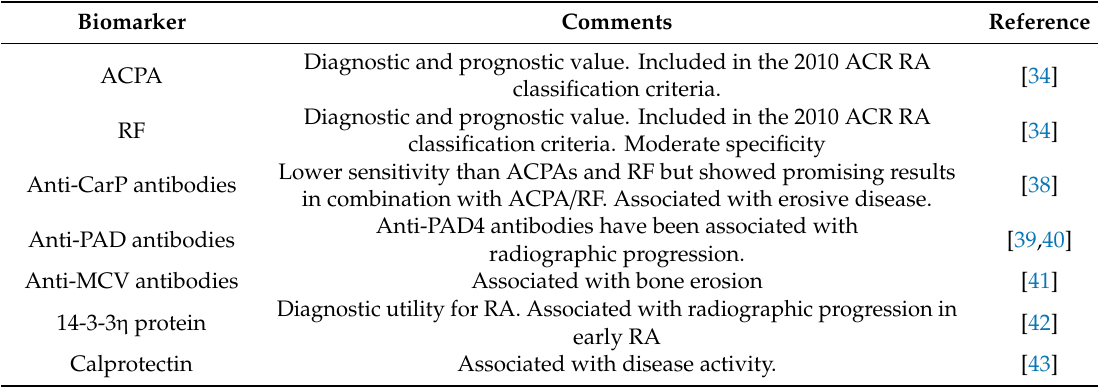
Table 2. Overview of biomarkers with potential utility in rheumatoid arthritis.